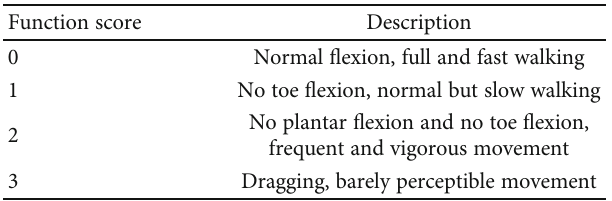
Table 1: Functional